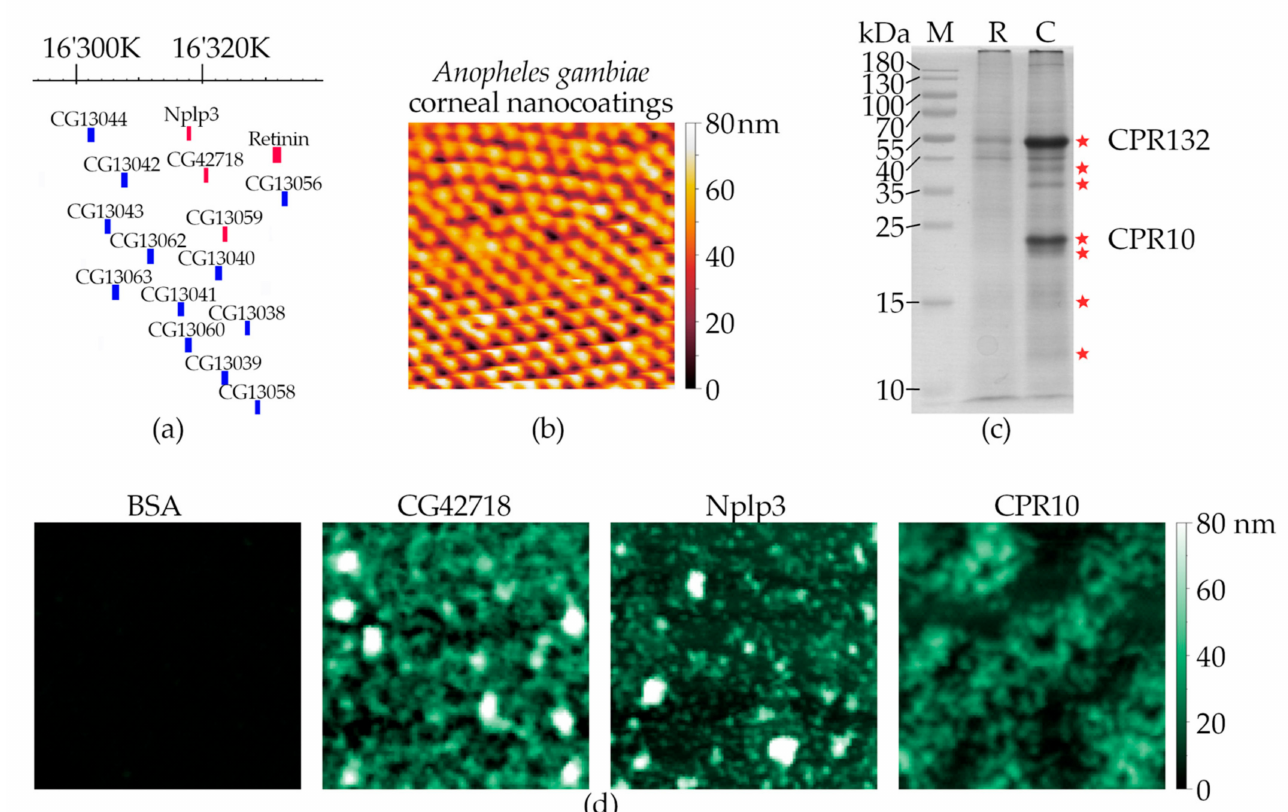
Figure 2. Identification of functional Retinin-like proteins. ( a ) On the chromosome arm 3 L of D. melanogaster , Retinin clusters together with several Retinin-like genes, encoding small-sized proteins with signal peptides, for extracellular secretion. Nplp3, CG13059, and CG42718 (marked in red, together with Retinin) were cloned and used in this work. The image is based on the GBrowse function of Flybase. Numbers on top are the chromosome’s nucleotide numbers. ( b ) AFM scan of A. gambiae corneal nanocoatings. ( c ) SDS-PAGE of retinal (R) and corneal (C) material from eyes of A. gambiae . Proteomic analysis of the corneal material identified two major proteins: CPR10 and CPR132. See Supplementary Materials Table S1, for peptides identified in the protein bands, marked with stars. ( d ) Topography of Retinin-like-based nanocoatings showed the self-assembly activity of these proteins, unlike of the control protein (BSA) but similar to that of Retinin and CG13059 [11,12]. Scans in ( b , d ) are 2 × 2 µ m; surface height is indicated by the color scale, shown to the right of the